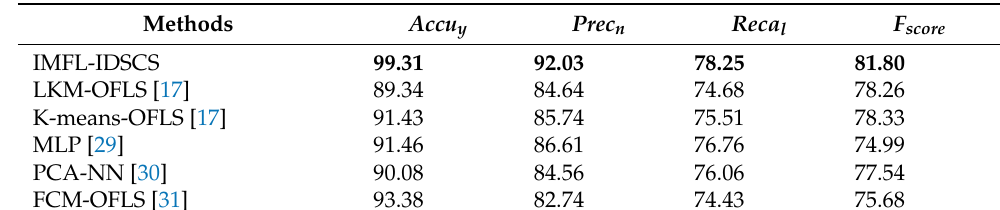
Table 4. Comparative analysis of IMFL-IDSCS system with other approaches.